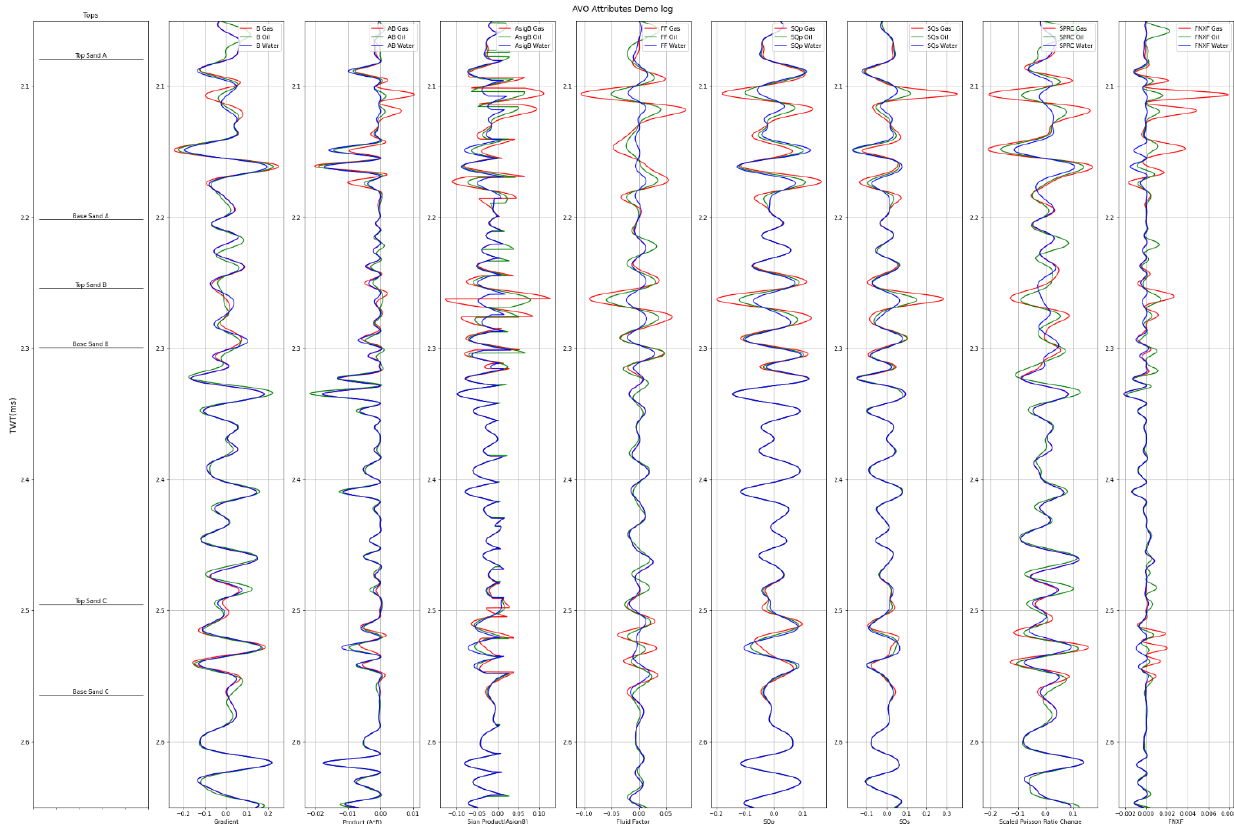
Figure 7. Selected AVO attributes for anomaly detection.